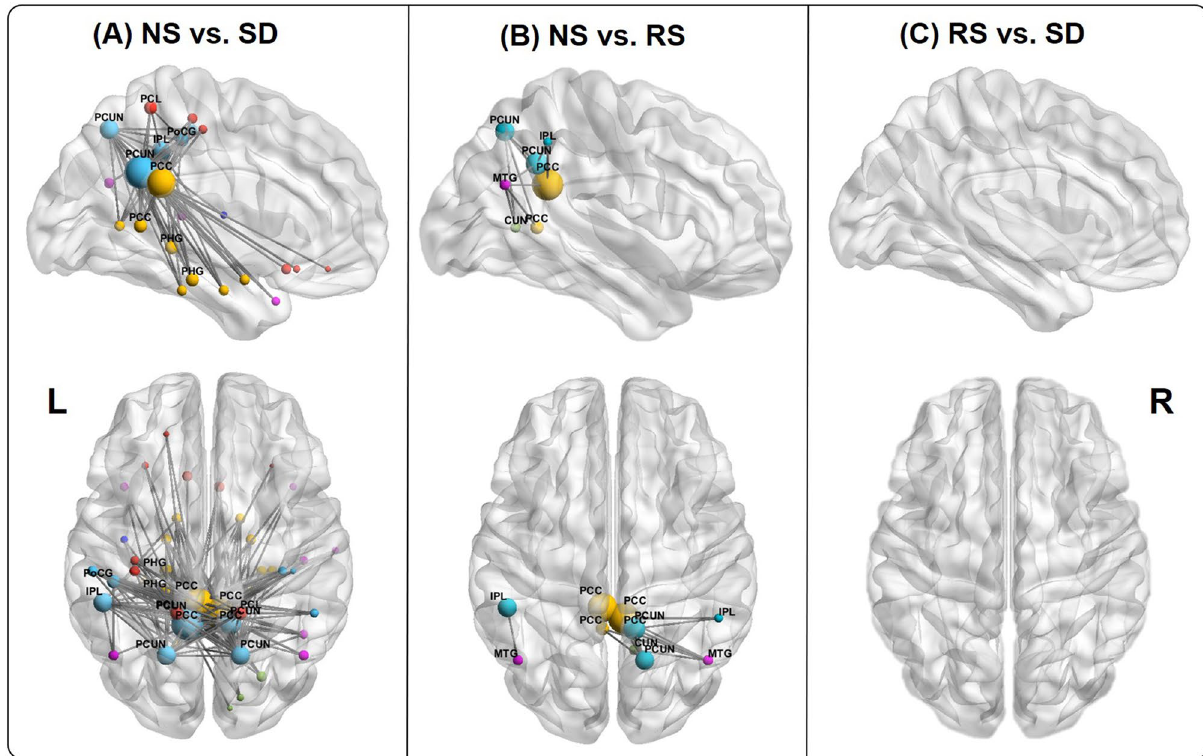
Figure 3. Alpha-band functional connectivity differences. ( A ) NS session versus SD session. Nodes with at least 14 connectivities are labeled, which contribute approximately 63% of the interactions to the network. ( B ) NS session versus RS session. All nodes are labeled because of the small number of connectivities. ( C ) RS session versus SD session. No significant connectivities were observed. Node size reflects the number of network connections. Abbreviations: PCC, posterior cingulate cortex; PCUN, precuneus; PoCG, postcentral gyrus; IPL, inferior parietal lobule; PCL, paracentral lobule; PHG, parahippocampal gyrus; MTG, middle temporal gyrus; CUN, cuneus. Color coding: parietal lobe, light blue; frontal lobe, red; limbic lobe, yellow; temporal lobe, purple; occipital lobe, green; insula, dark blue. The figure was visualized with the BrainNet Viewer (available at http:// www.nitrc .org/proje